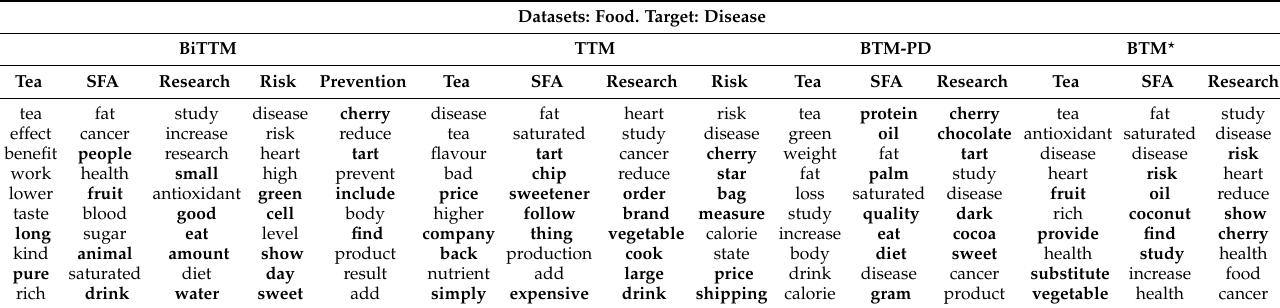
Table 7. The contents of topics on target “disease” in long texts food . Datasets: Food. Target: